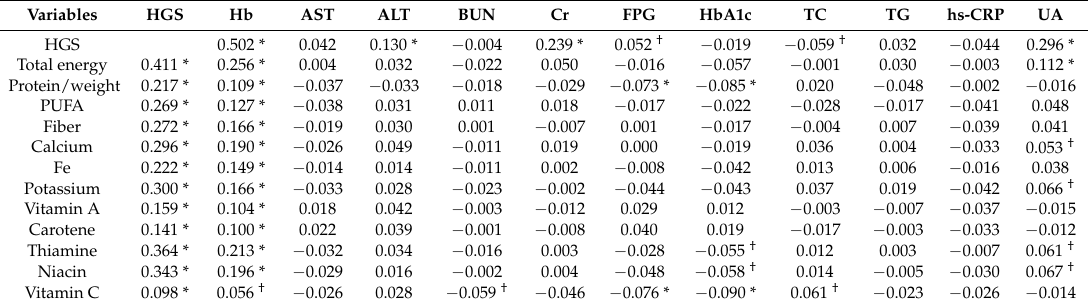
Table 3. Correlations of handgrip strength with nutritional intakes in study